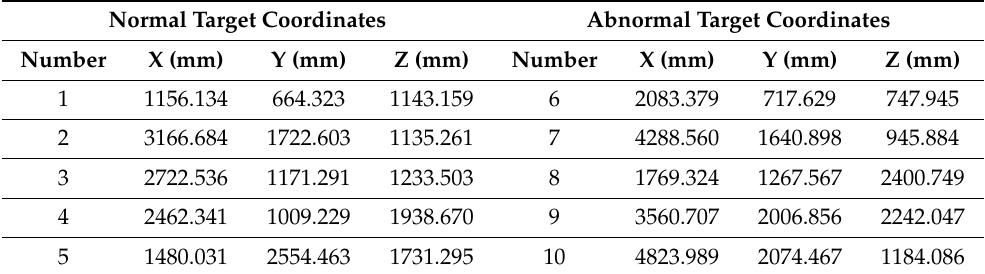
Table 4. Normal/abnormal target coordinate results.